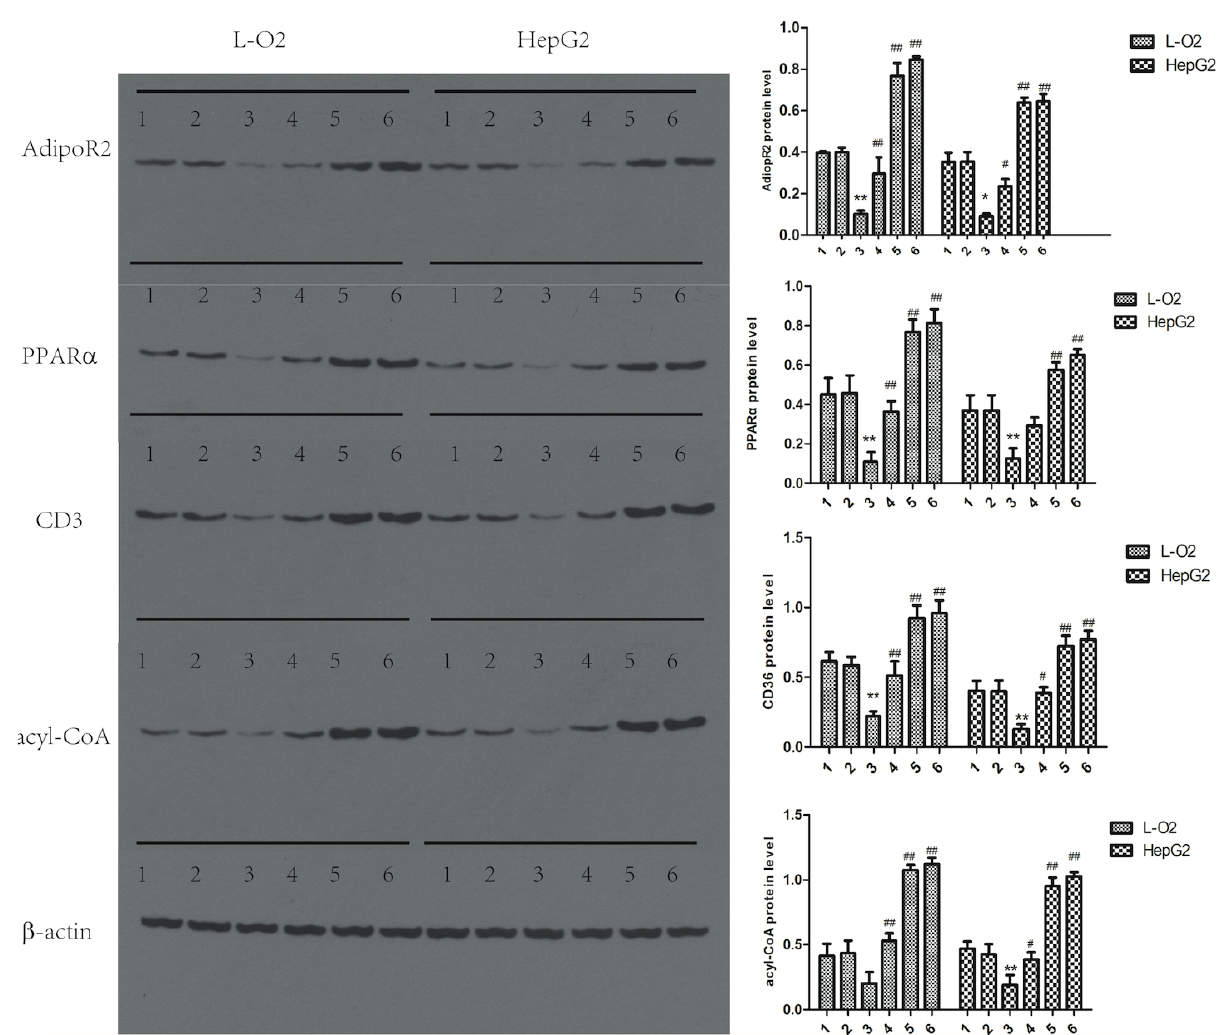
Figure 6: Changes in AdipoR, PPARα, CD36, and acyl-CoA protein expression. 1: Normal group; 2: blank control group; 3: model group; 4: low dose group; 5: medium dose group; 6: high dose group. *p<0.05, **p<0.01vs the normal group. #p<0.05, ##p<0.01 vs the model